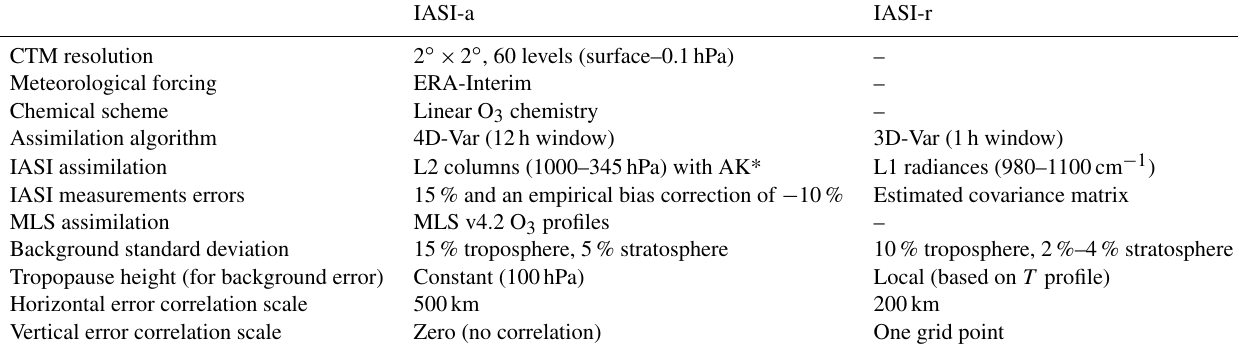
Table 1. Configuration of the IASI-r and IASI-a (Peiro et al., 2018) experiments. The dash symbol indicates that the configuration is the